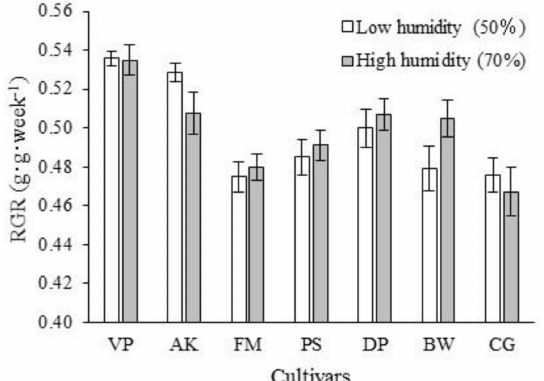
Figure 2. Mean relative growth rate (RGR) in seven lisianthus cultivars under low and high air humidity treatments. Cultivars are arranged in order of mean RGR for the low and high humidity treatments. Error bars represent SE ( n =